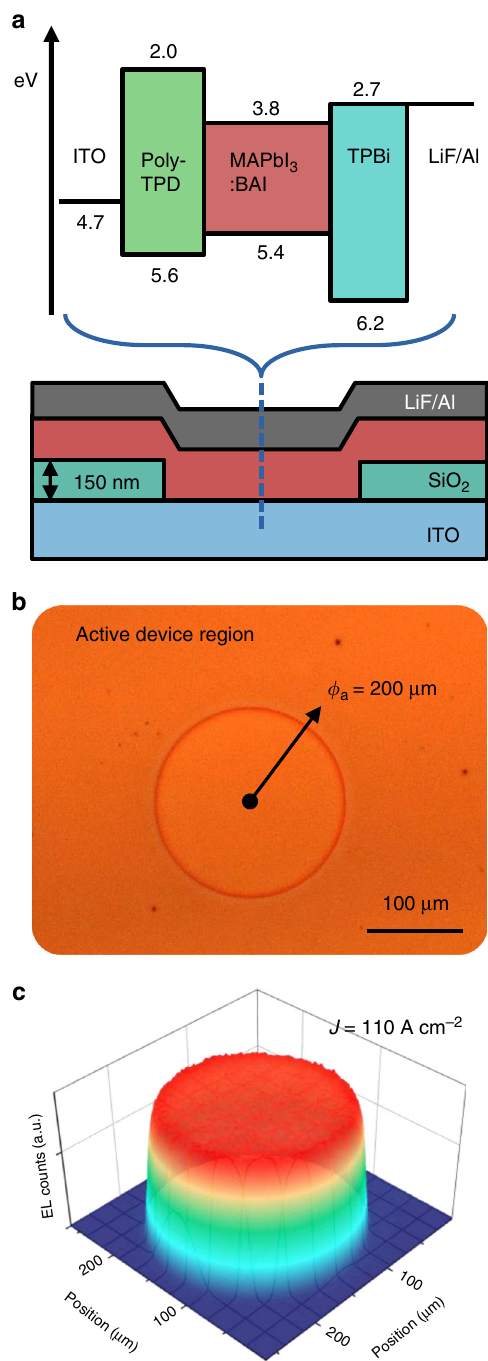
Fig. 1 Device architecture. a Energy level diagram and schematic of the device architecture, which consists of ITO (150 nm)/poly-TPD (25 nm)/ MAPbI 3 :BAI (100:20, 70 nm)/TPBi (40 nm)/LiF (1.2 nm)/Al (100 nm). The active area is de fi ned by patterning openings in the insulating SiO 2 (150 nm) layer shown in the bottom graphic. b Optical microscope image of a typical 200 μ m diameter device. c Electroluminescence intensity pro fi